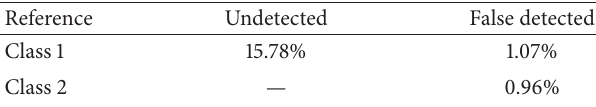
Table 2: Results of optimal selection by SVM. Table 3: Classification rate.